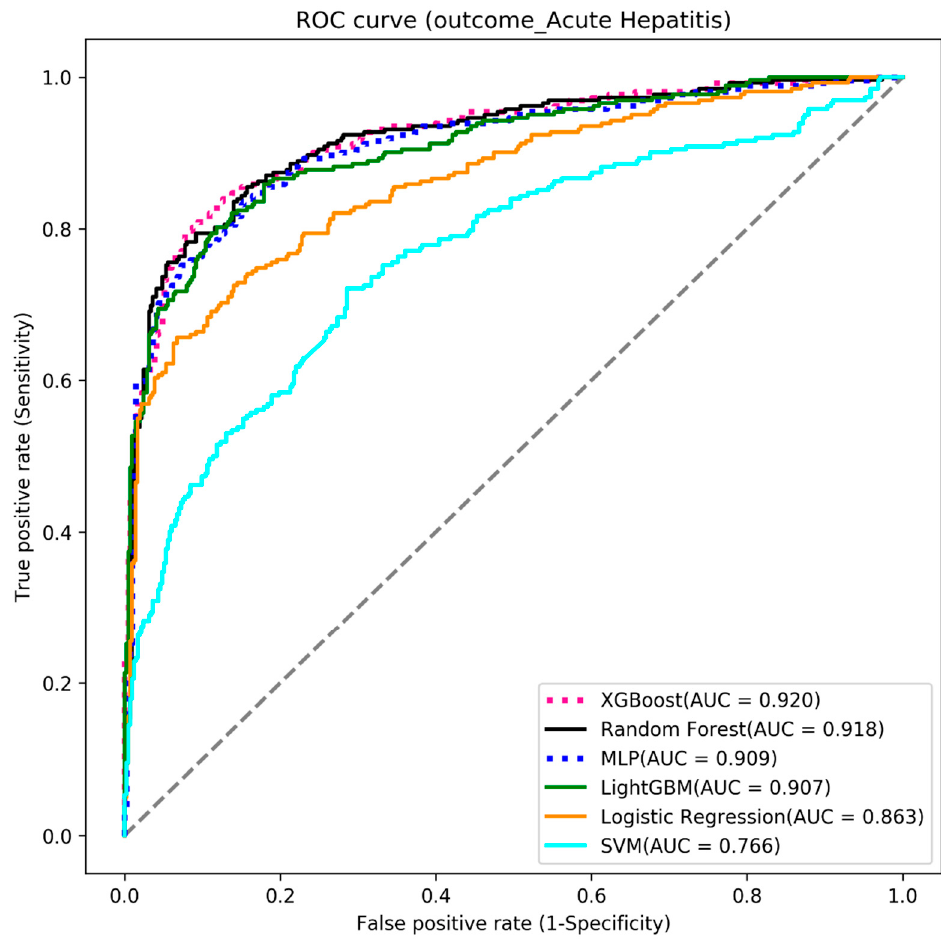
Figure 5. The ROC curve of the acute hepatitis models.